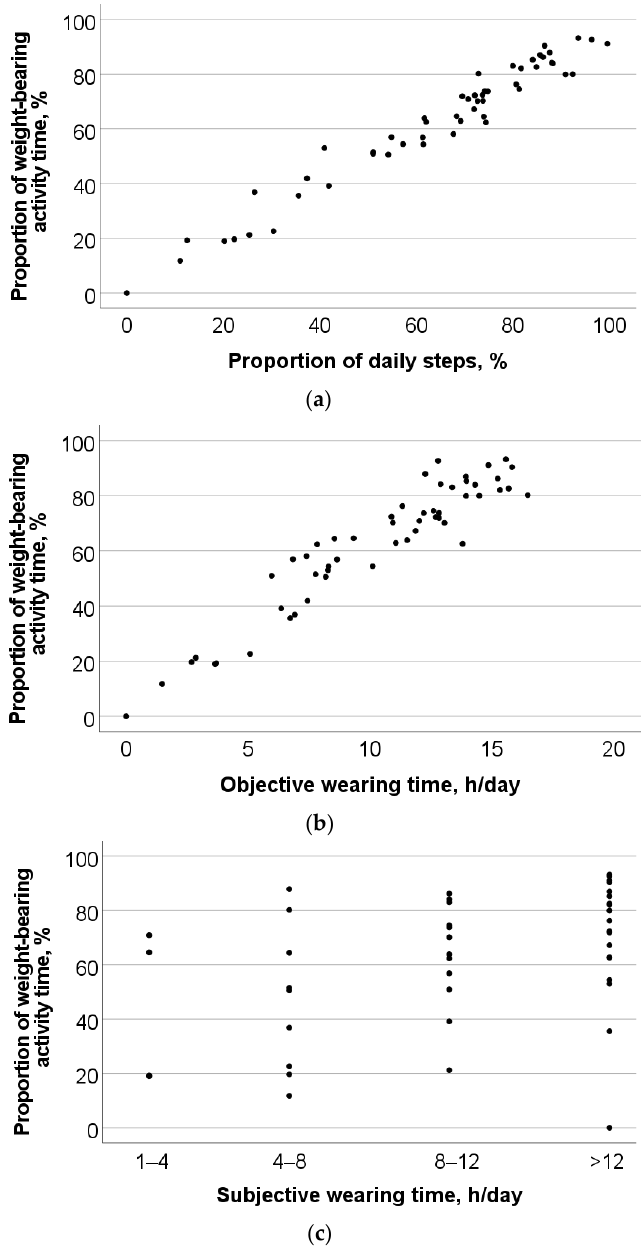
Figure 2. Scatter plots and Spearman’s correlation coefficients (r) for the associations with the reference measure: ( a ) r = 0.96 ( p < 0.001), ( b ) r = 0.91 ( p < 0.001), ( c ) r = 0.42 ( p = 0.004). Proportion of daily steps prescribed footwear was worn had almost perfect agree- ment ( Κ = 0.93, 95% CI not possible to calculate), objective wearing time had strong agree- ment ( Κ = 0.85, 95% CI not possible to calculate), and subjective wearing time had minimal agreement ( Κ = 0.38, 95% CI: 0.15–0.61) with the reference adherence measure. The AUC was outstanding for proportion of steps (0.96–1.00), ranged from excellent to outstanding for objective wearing time (0.89–0.99) and ranged from not acceptable to excellent for sub- jective wearing time (0.67–0.81), for the different cut-offs used to classify participants as highly or lowly adherent (Table 2).